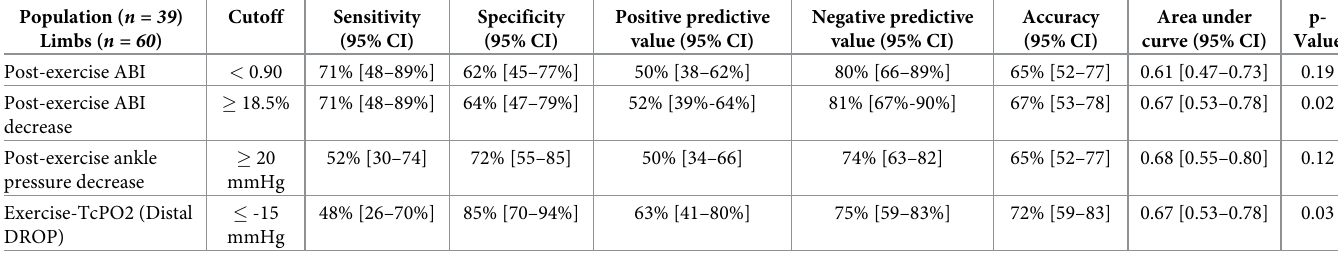
Table 4. Exercise test characteristics for identifying stenosis � 50% in any limb among the 60 limbs with normal ABIs ( >